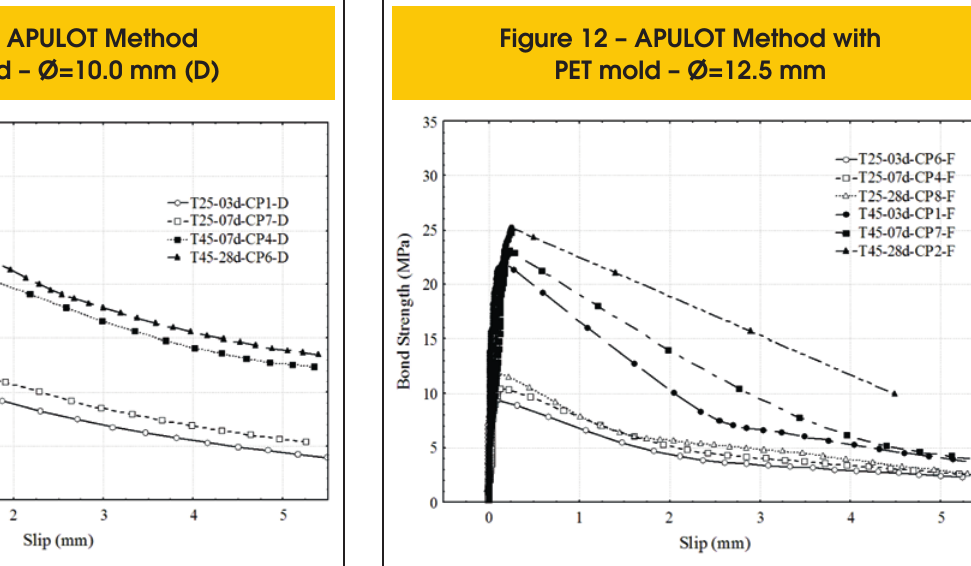
Figure 12 – APULOT Method with PET mold – Ø=12.5